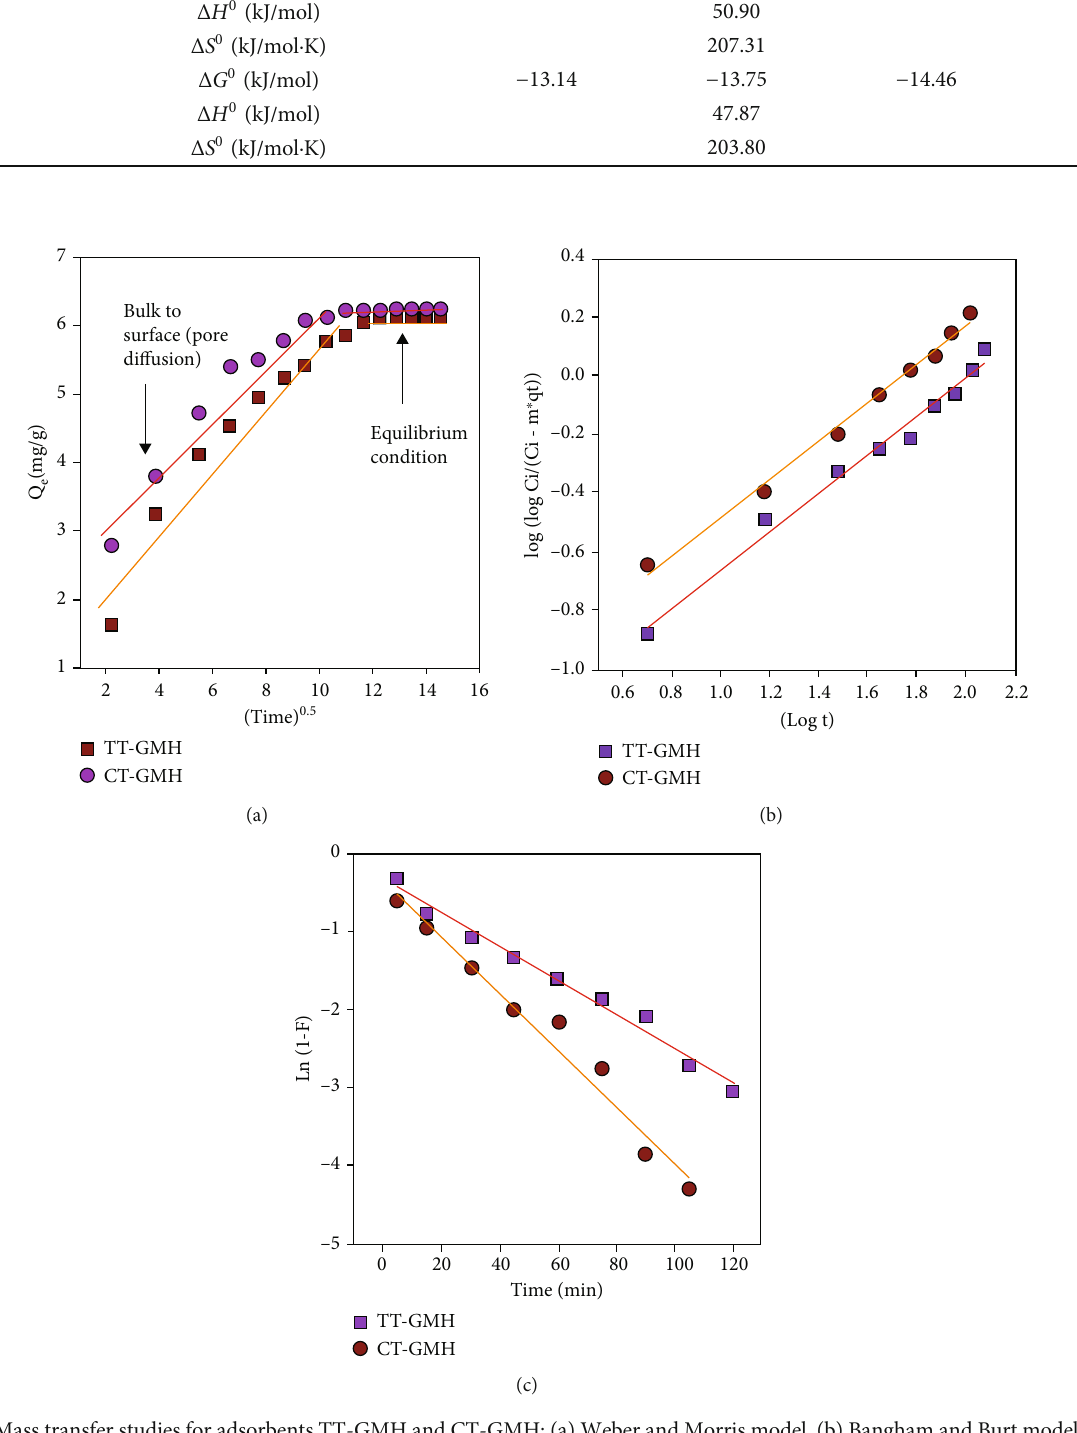
Figure 8: Mass transfer studies for adsorbents TT-GMH and CT-GMH: (a) Weber and Morris model, (b) Bangham and Burt model, and (c) layer/ fi lm di ff usion model.